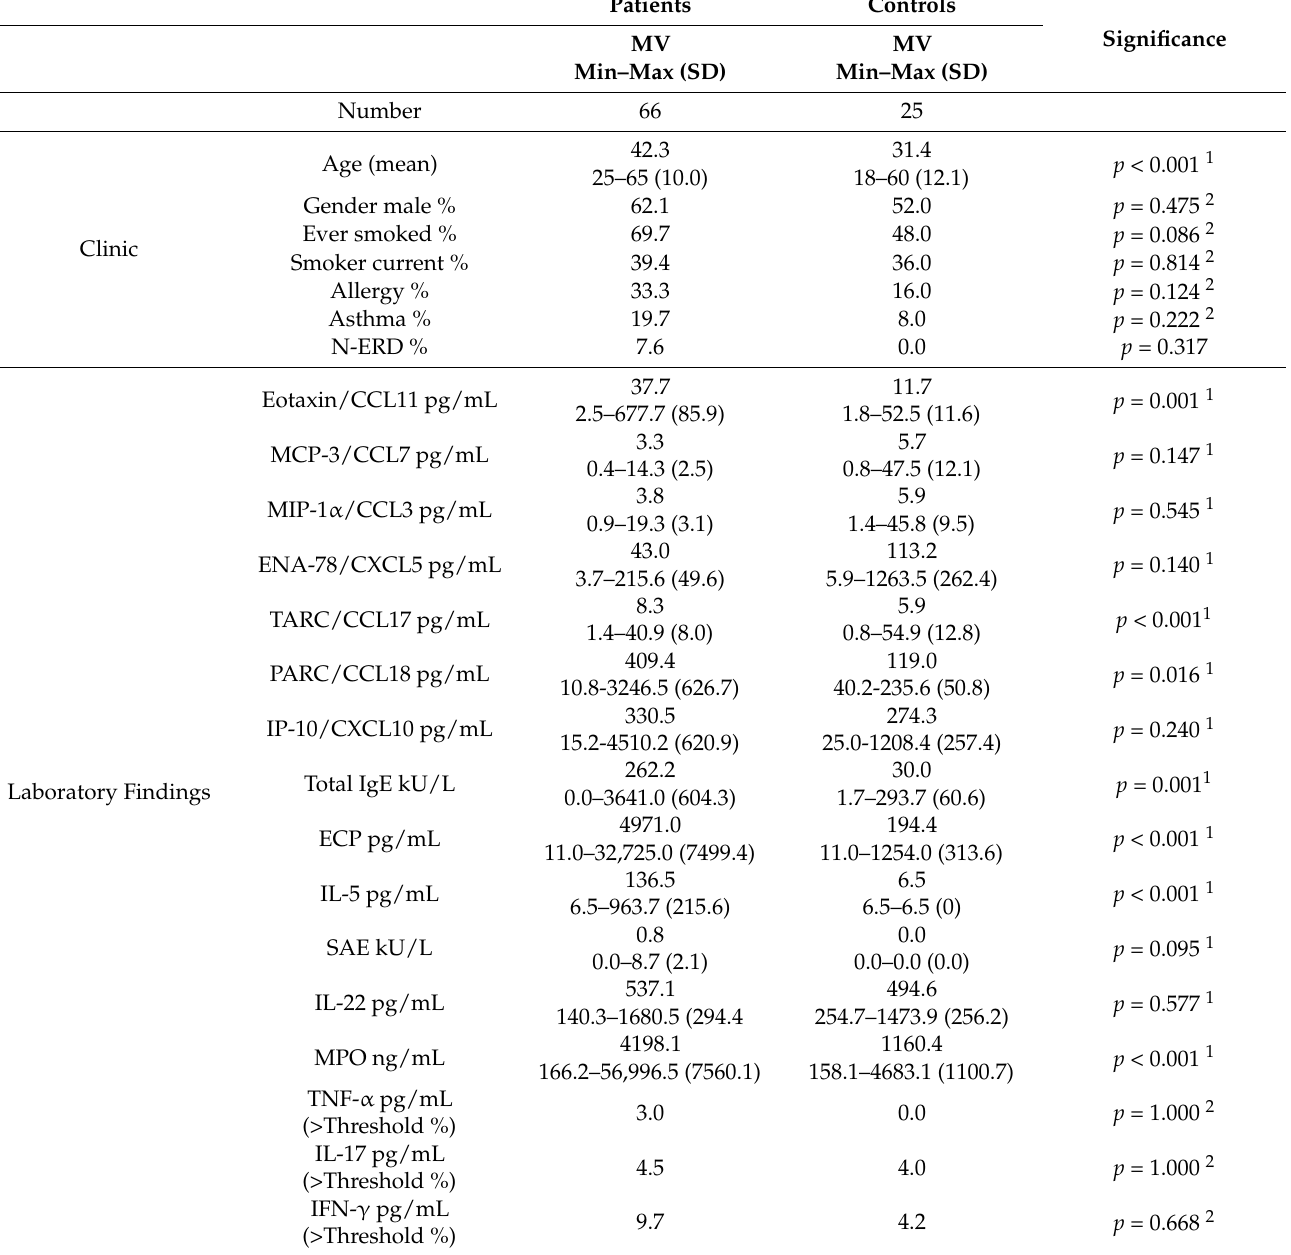
Table 3. Descriptive statistics of CRS patients and control